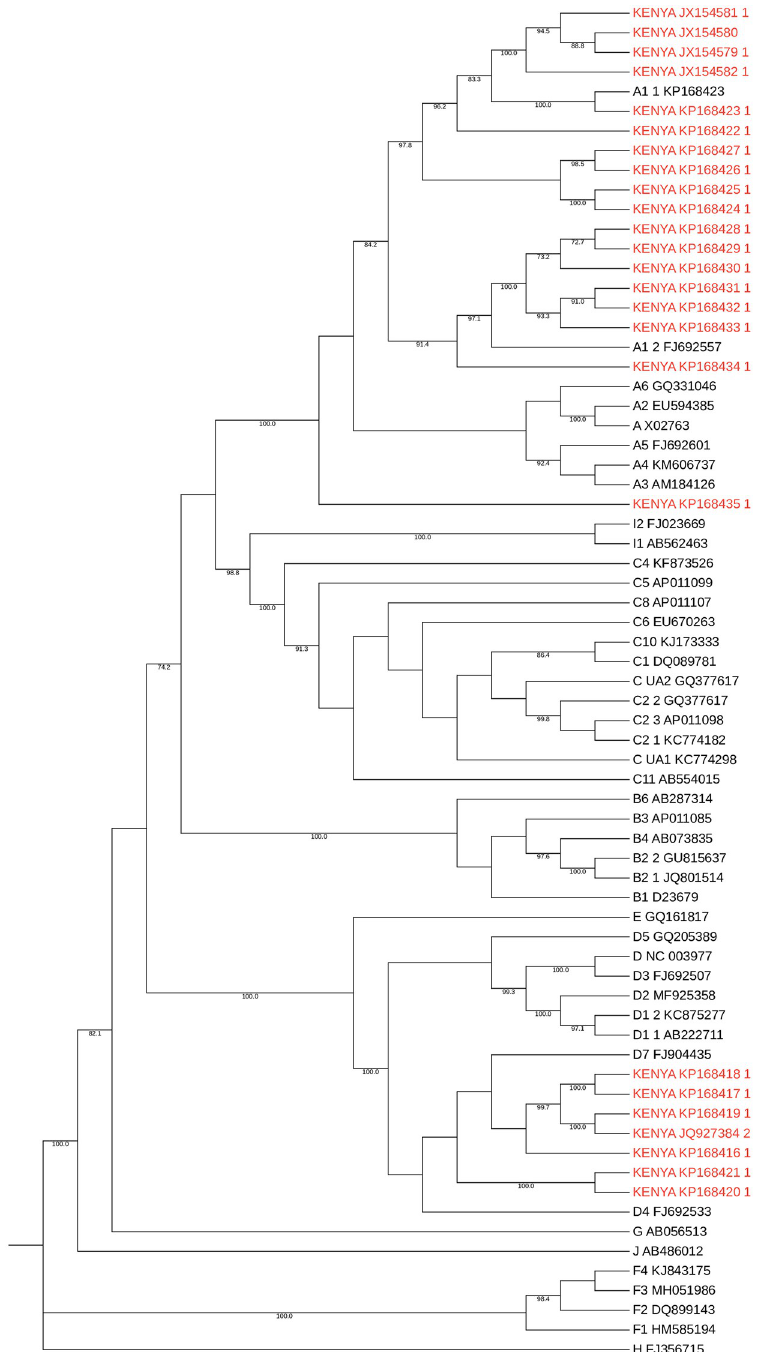
Fig 5. Maximum likelihood phylogenetic tree of full-length consensus HBV sequences from Kenya. Kenyan sequences are those published in GenBank (downloaded 1 st Dec 2021) and are shown in red alongside genotype reference sequences in black (1000 bootstrap replicates were performed, and bootstrap support of � 70% are indicated. Reference sequences from McNaughton et al. (2020) [11].